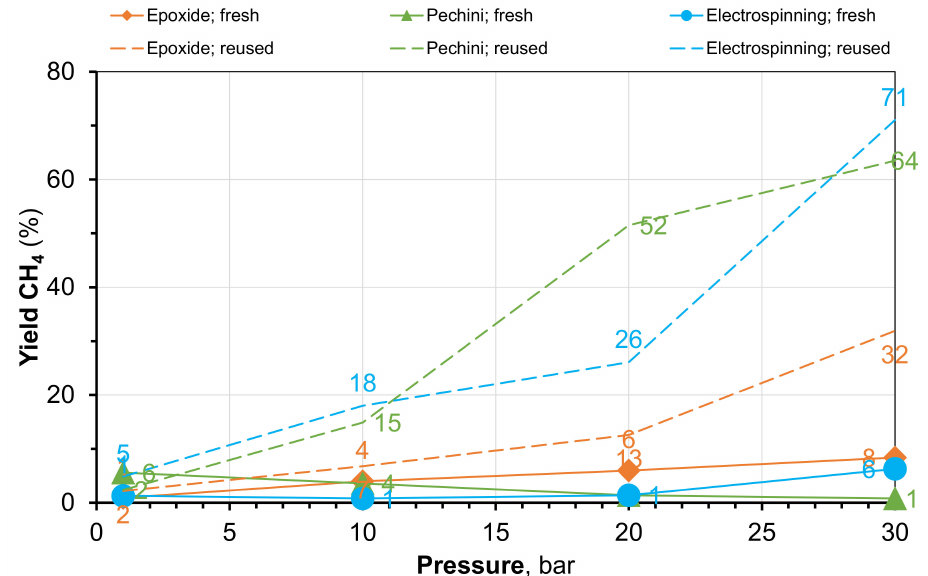
Figure 4. Methanation of CO 2 over reused cobalt–cerium bimetallic oxides at 300 ◦ C without pre- treatment under hydrogen: effect of preparation method on yield to CH 4